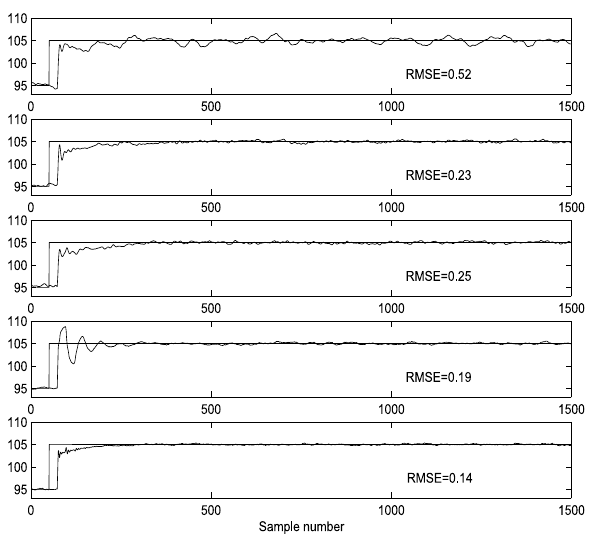
Figure 4: Step responses for different control structures (with typical RMSE values based on 100 Monte Carlo